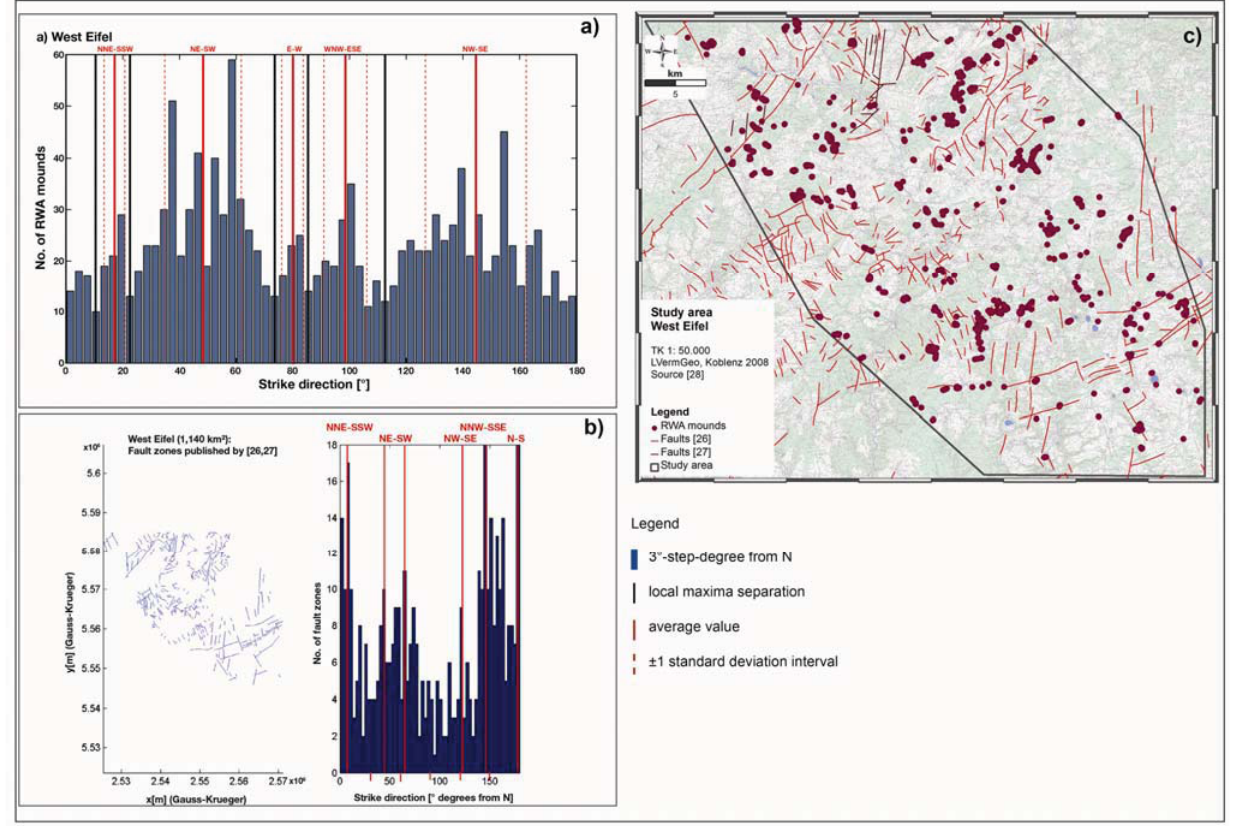
Figure 7. Hough transform analyses of spatial distribution of RWA mounds (degrees from N) in the 1,140 km² West Eifel study area ( a ) in comparison with fault zones (degrees from N) ( b ) and in a map presentation ( c ) show that the RWA mounds are not randomly distributed but that there are preferential alignment directions of RWA mounds that correspond to those of the main fault